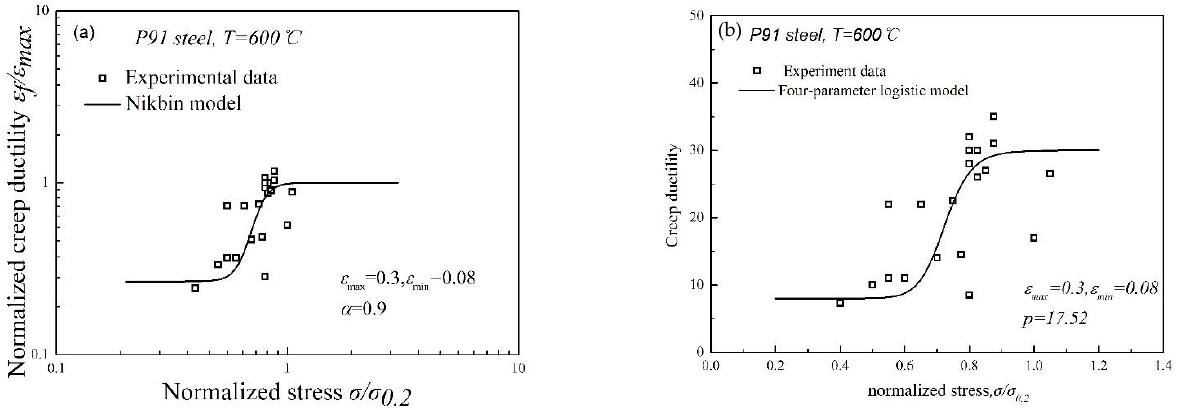
Figure 5. Creep ductility against the normalized stress in the Nikbin model [1,34] ( a ) and the four-parameter model [33,34] ( b